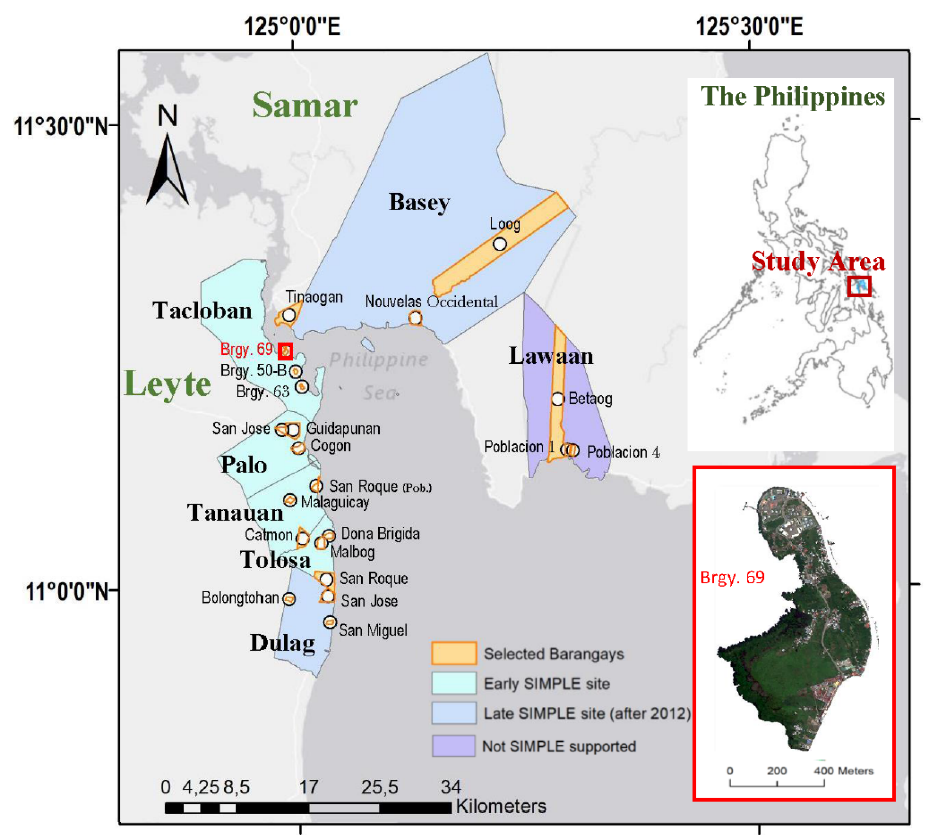
Figure 2. Municipalities included in this study, and overview of Barangay 69. Notes: Brgy. = barangay; SIMPLE = Sustainable Integrated Management and Planning for Local Government Ecosystems intervention; GIZ = German agency for technical